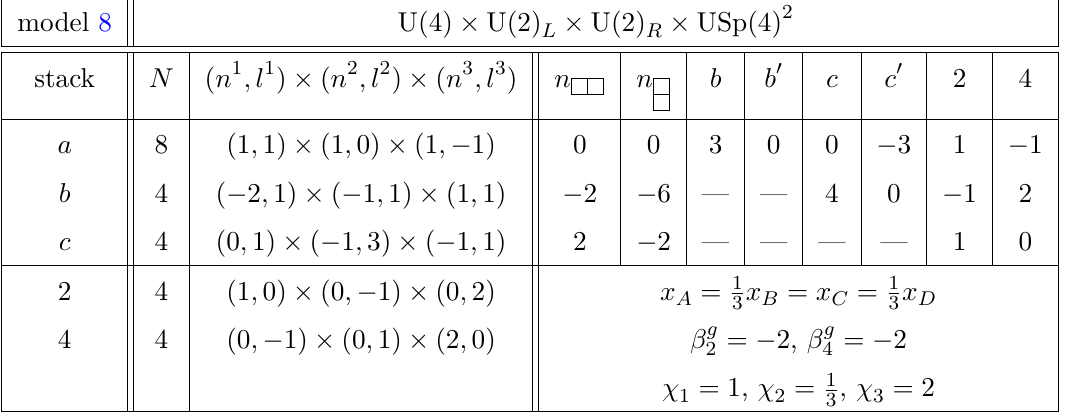
Table 8 . D6-brane configurations and intersection numbers of Model 8, and its MSSM gauge